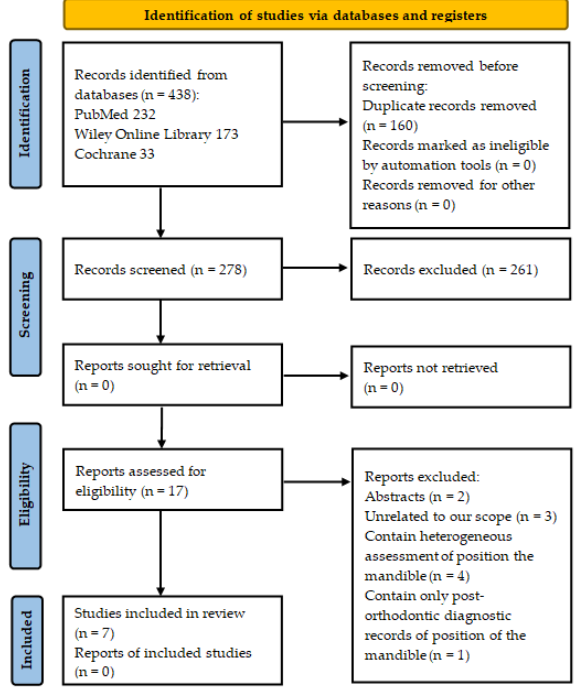
Figure 1. PRISMA flow diagram.